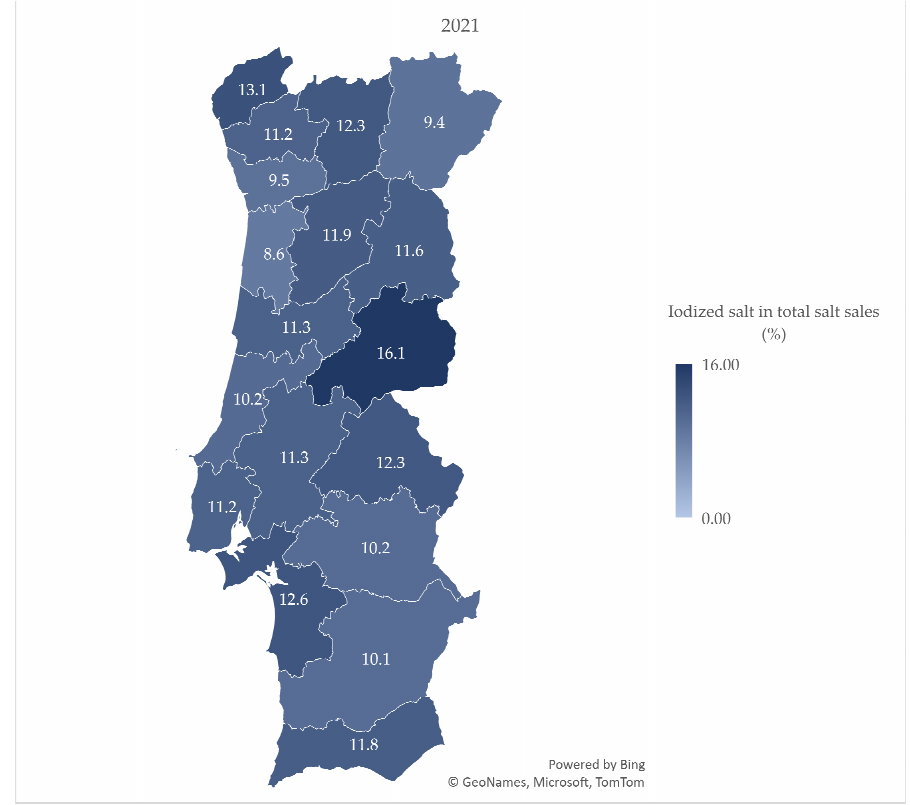
Figure 3. Percentage of iodized salt in total salt sales by district in